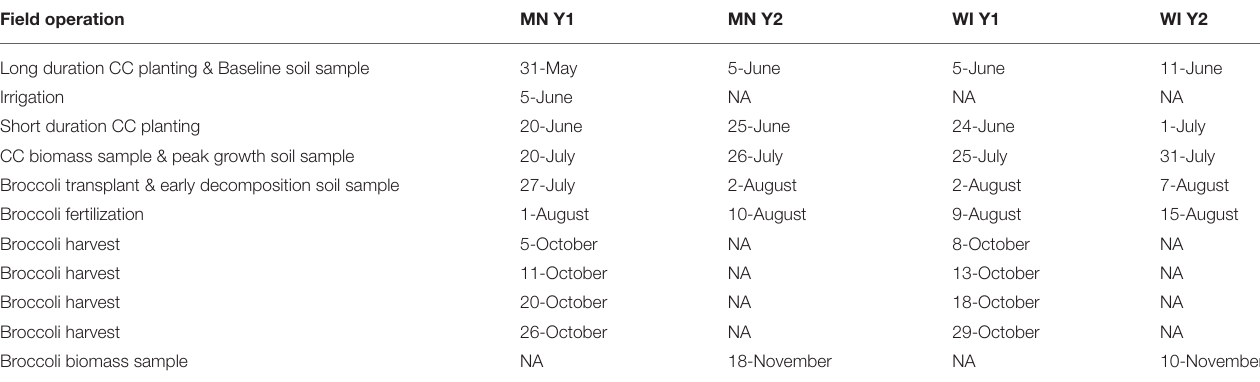
TABLE 2 | Field management schedule for Y1 and Y2 field